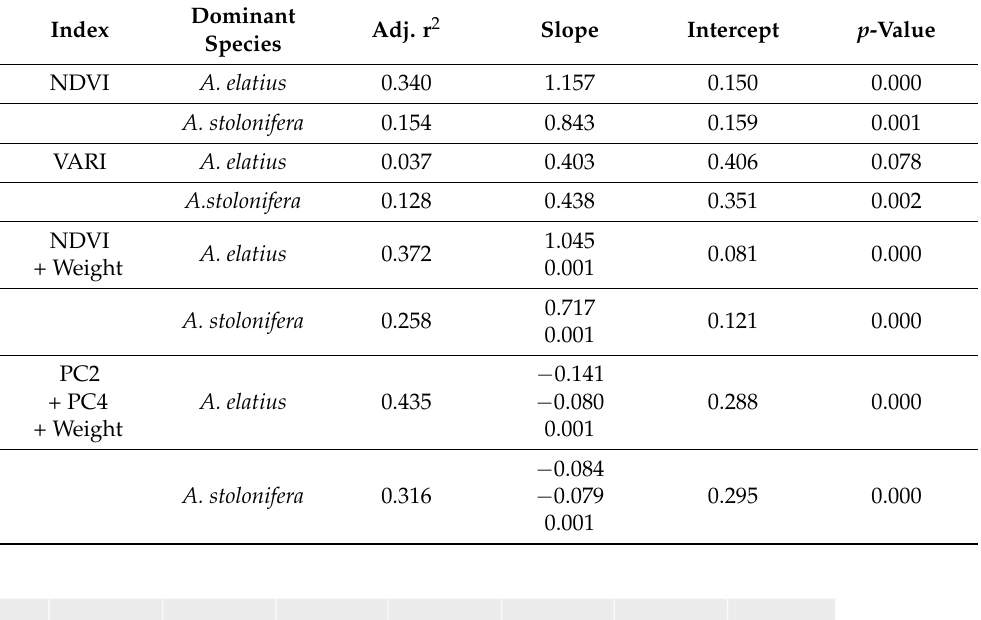
Table 5. Summary of Models for Separate Vegetation Types.